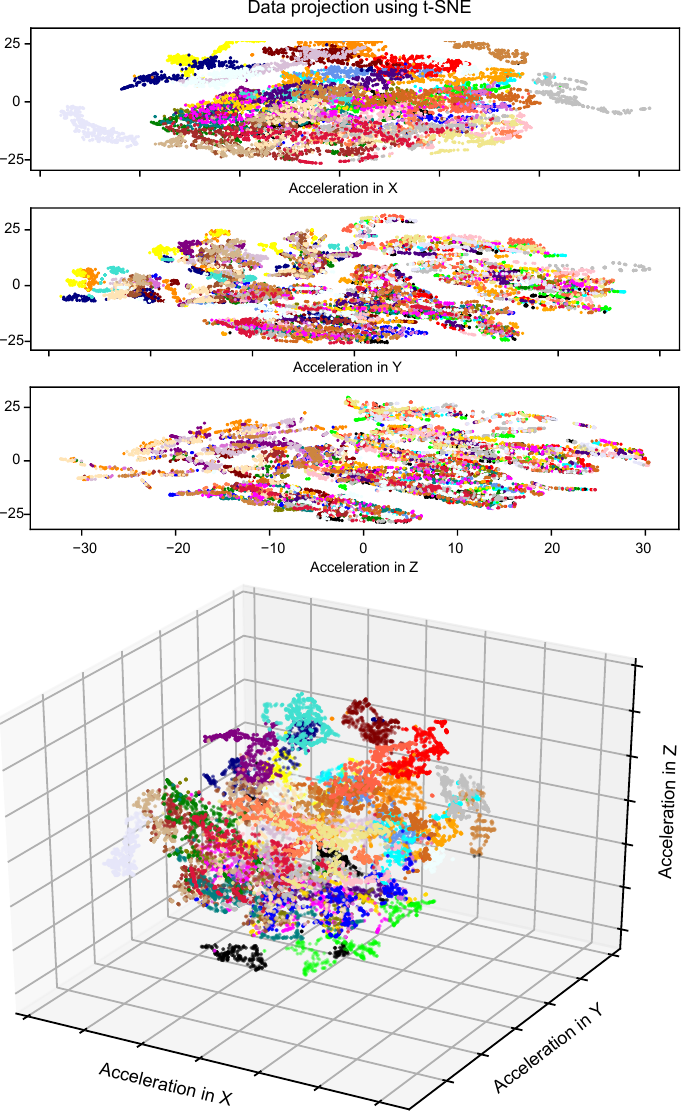
Figure 5. Distribution of the features’ space. ( Above ) For X, Y, and Z axes. ( Below ) For the three